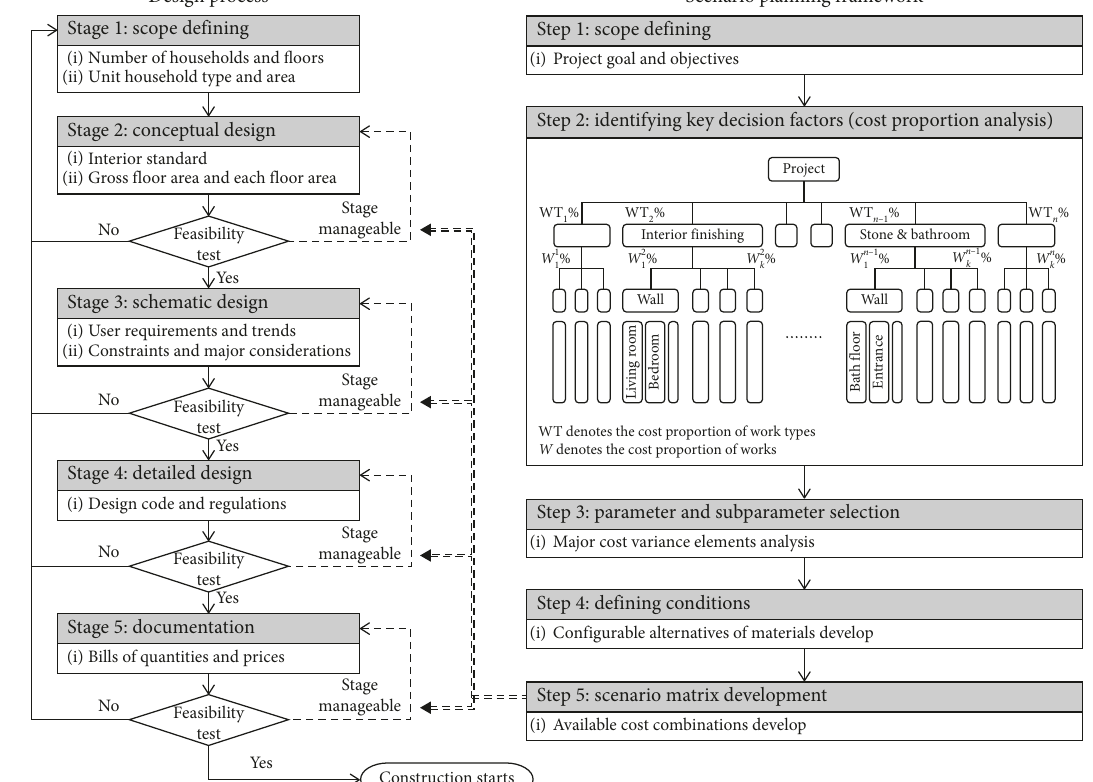
Figure 2: Scenario-planning framework and expected function in design